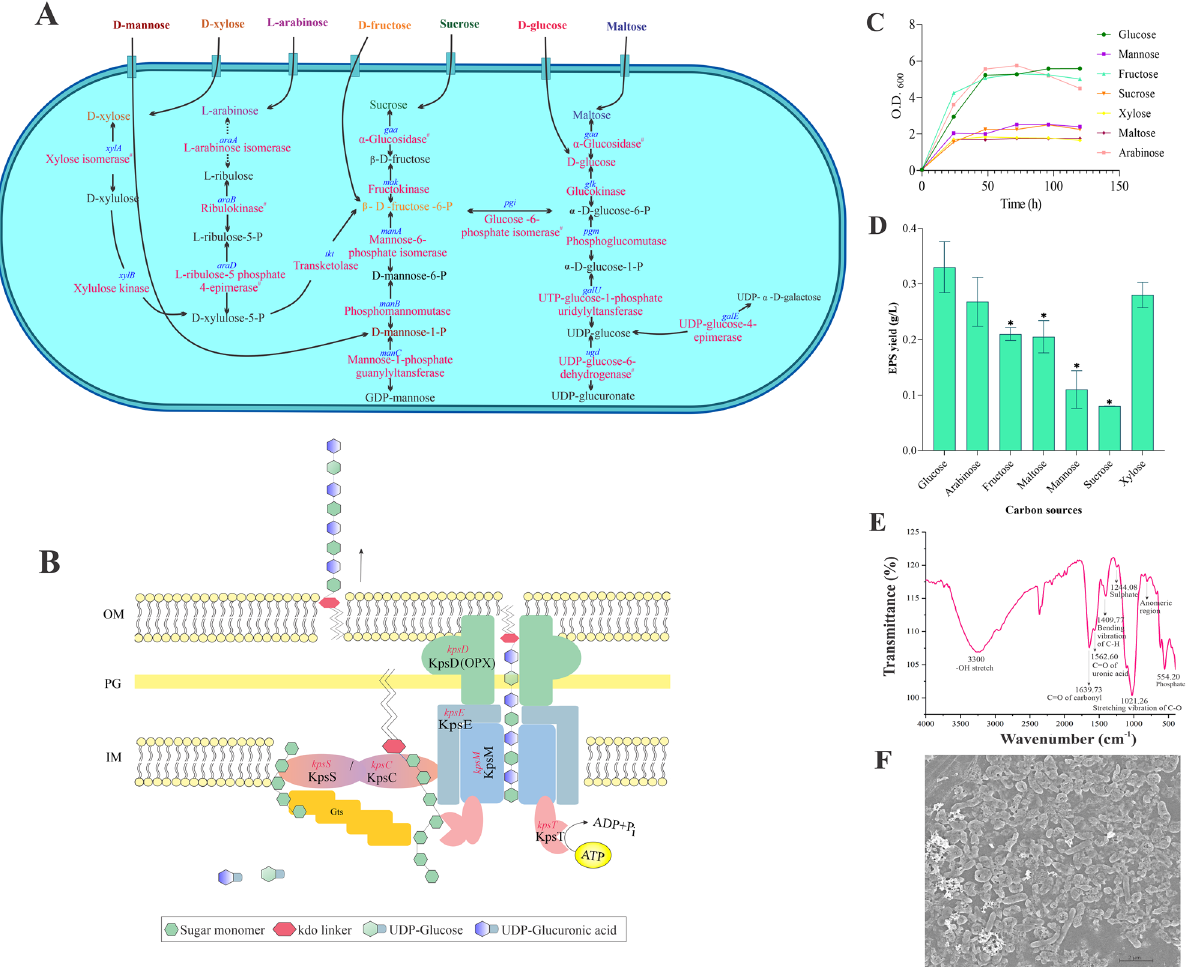
Figure 2. ( A ) Genes identified for the polysaccharide biosynthesis in H. malpeensis YU-PRIM-29 T from the genomic data. # Results obtained from tBLASTn analysis and the details are provided in the Supplementary Tables S2 and S10. ( B ) ABC transporter-dependent assembly and transport of polysaccharides in H. malpeensis . ( C ) Influence of carbon source on growth of H. malpeensis . Data points are OD 600 values obtained from broth cultures incubated with different carbon sources recorded at different time points. ( D ) EPS yield obtained from different carbon sources at 48 h, *indicates p value < 0.001. Data points are mean ± SD and n = 3. ( E ) FTIR spectra of EPS with peaks showing the important bands and ( F ) FESEM image of biofilm formed by H. malpeensis on glass is identified using PATRIC, Rapid Annotations using Subsystems Technology (RAST), dbCAN2 and Prokka annotation of which four are found in the EPS cluster hinting their role in transport of the produced EPS. The detailed list of the glycosyltransferases is given in Table 4. For the export of EPS outside the cell, H. malpeensis is proposed to follow an ABC transporter-dependent pathway 16 . The genes coding for Kps proteins involved in ABC transporter-dependent pathway such as kpsD , kpsM , kpsE , kpsT, kpsS and kpsC are identified in the genome. The kps gene cluster has been predicted using antiSMASH. The structural details of these proteins were searched using InterPro database. The KpsS and KpsC proteins (β-Kdo transferases) synthesise a capsular polysaccharide export system protein (oligo-Kdo linker); KpsT is an ATP binding protein; KpsM is an ABC transporter permease protein that interacts with KpsT; KpsD is an export system periplasmic protein and KpsE is an export system inner membrane protein (Fig. 2B). The possible genes involved in EPS modifications were searched using Prokka annotation and tBLASTn. A gene ugd coding for UDP-glucose-6-dehydrogenase (EC 1.1.1.22) involved in the conversion of the nucleotide sugar UDP-glucose to UDP-glucuronic acid is found. As the ABC transporter-dependent pathway is mainly associated with CPS, we followed extraction procedures for both CPS and EPS and observed that EPS was predominantly extracted. Ability of the bacteria to produce EPS was tested using different carbon source supplementation. Among the carbon sources tested based on the genomic data, the growth was favoured by all the sugars (Fig. 2C), while, the EPS yield was higher in D-glucose, D-xylose, D-fructose and L-arabinose supplemented media (Fig. 2D). The EPS yield in the media containing D-mannose and maltose were significantly (p < 0.001) lower compared to the others. Biochemical analysis of the